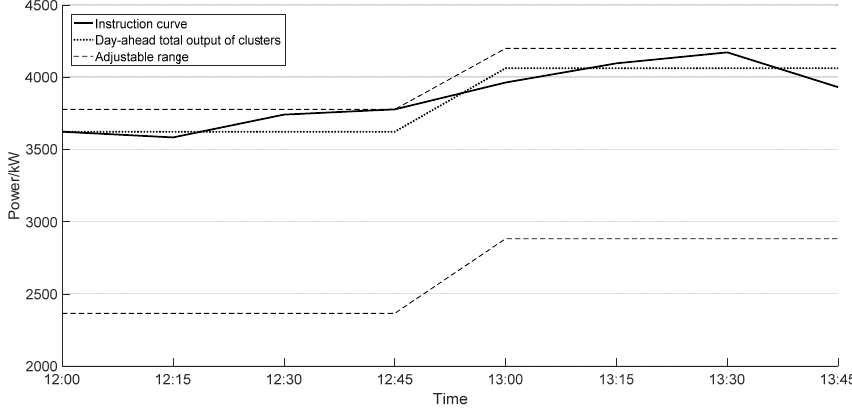
Figure 9. Grid ‐ to ‐ system instruction curve. Figure 9. Grid-to-system instruction